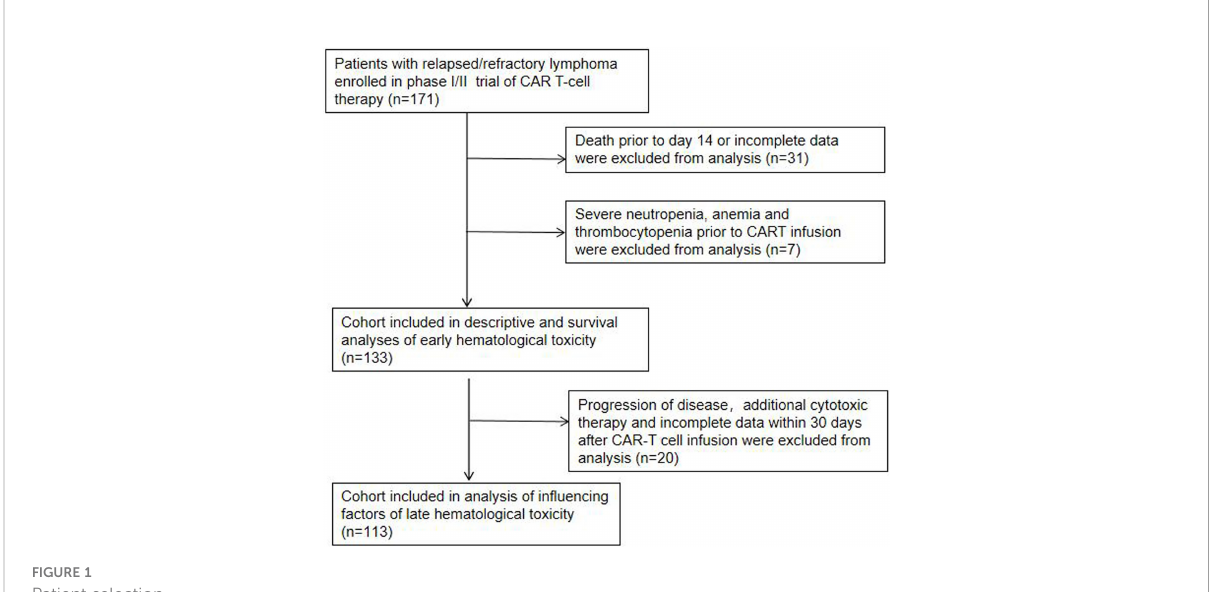
FIGURE 1 Patient